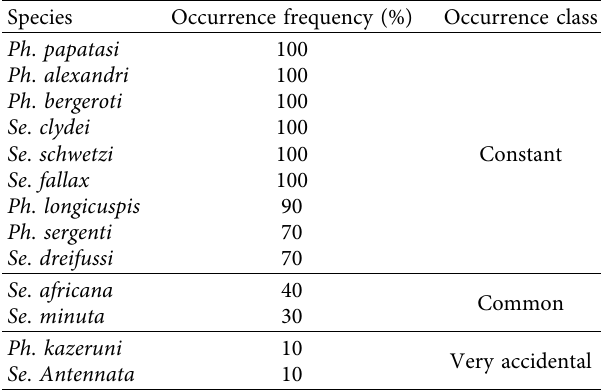
Figure 2: Spatial distribution of sand fies collected in Zagora Province. Table 3: Degree of presence of sand fies in study